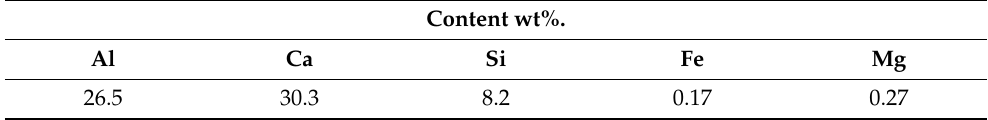
Table 1. Chemical analysis of the slag produced by aluminothermic reduction. Content wt%.